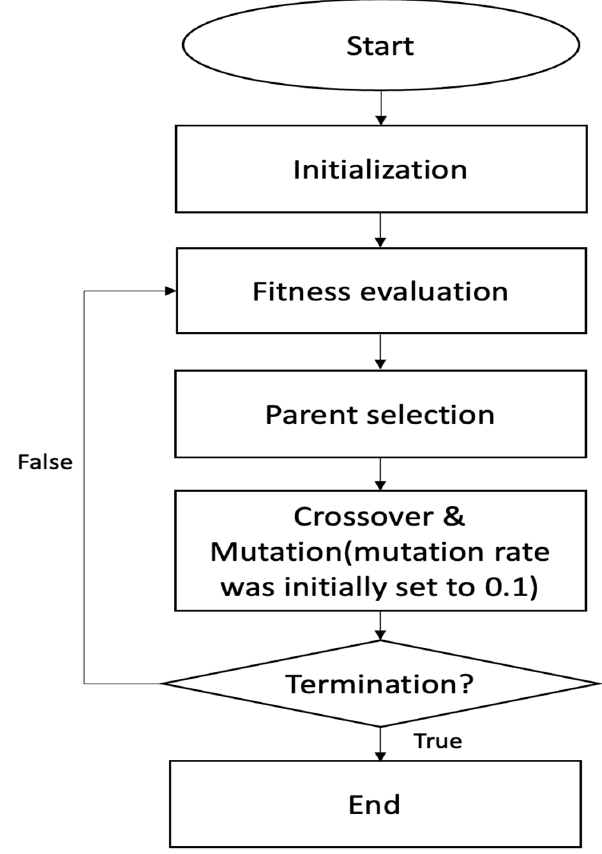
Figure 1. Flow chart of the genetic algorithm.